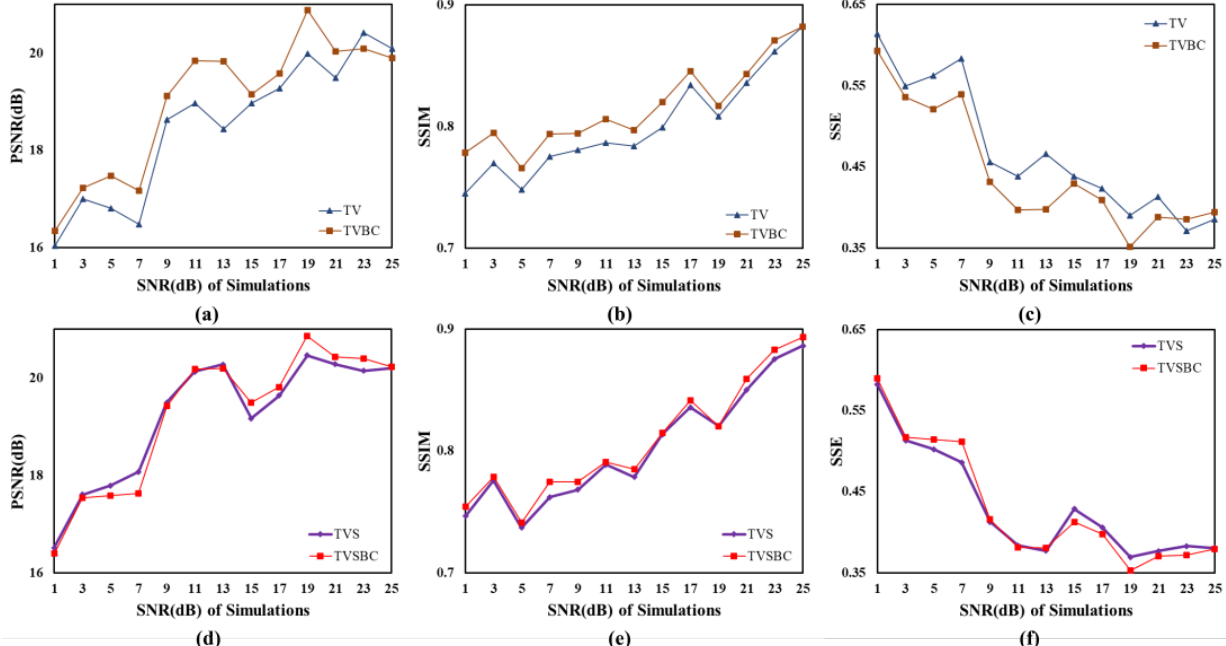
Figure 8. Different evaluated results under different SNRs. ( a – c ) PSNR, SSIM, and SSE for TV and TVBC, respectively. ( d – f ) PSNR, SSIM, and SSE for TVS and TVSBC, respectively.